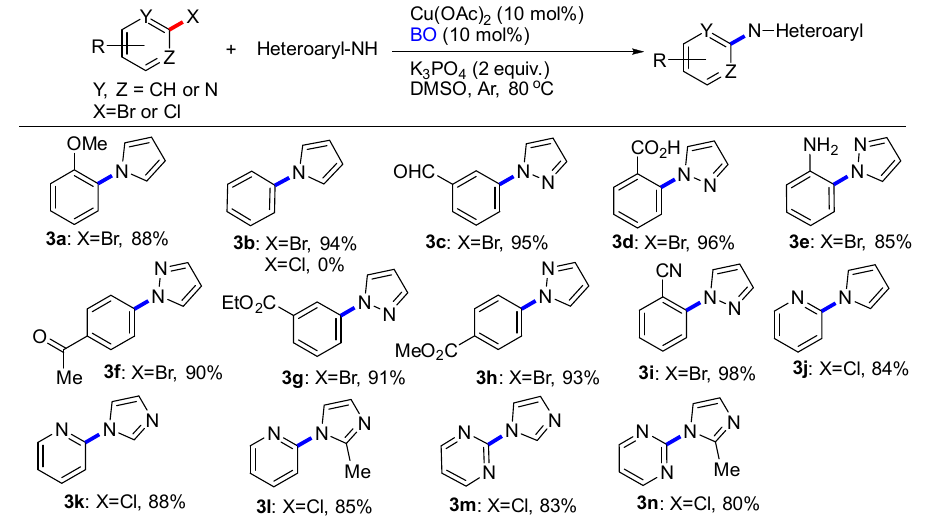
Molecules 2019 , 24 , x